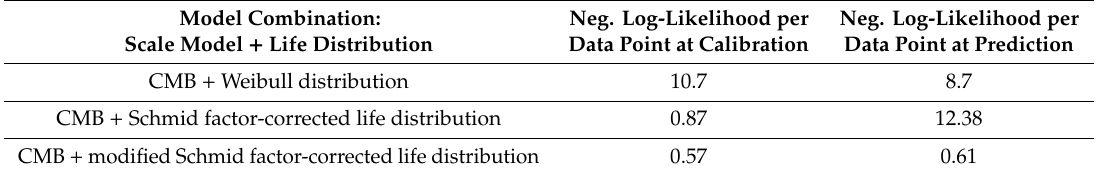
Table 6. Values of negative Log-Likelihood for the di ff erent distribution